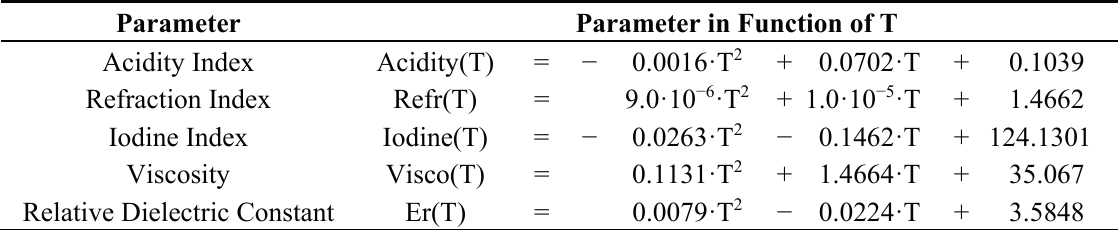
Table 2. Polynomial adjustment referring to the physical-chemical analysis